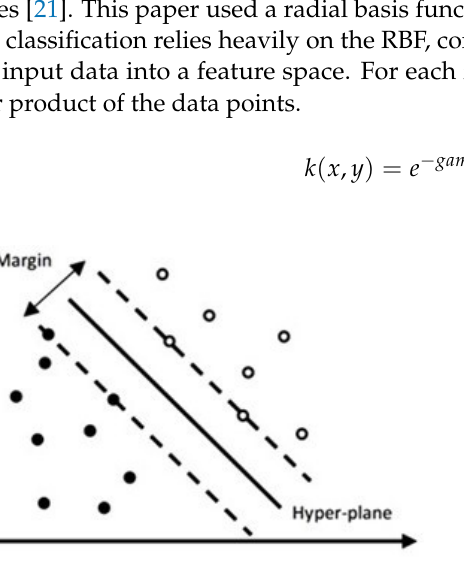
Figure 1. The proposed model’s overall working process.